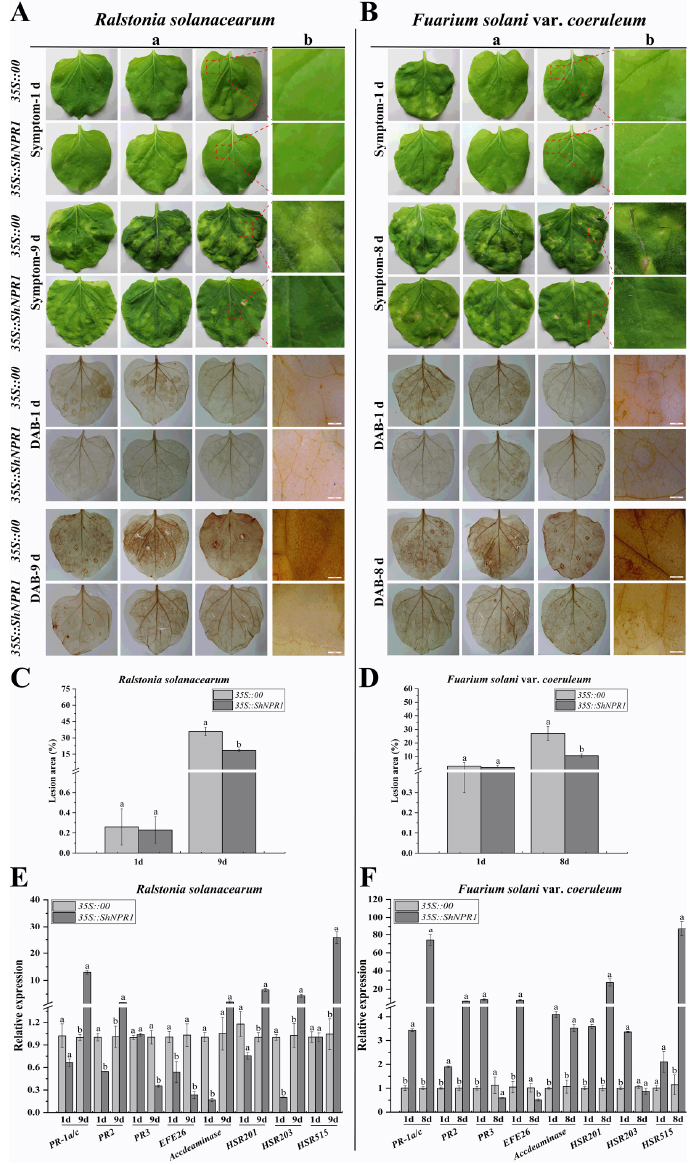
Figure 10. The immune effect of transient overexpression of ShNPR1 in Nicotiana benthamiana after inoculation with Ralstonia solanacearum and Fuarium solani var . coeruleum . ( A ) The disease symptoms and 3,3-diaminobenzidine (DAB) staining of N. benthamiana leaves at 1 day and 9 days post-inoculation with R. solanacearum . ( B ) The disease symptoms and DAB staining of N . benthamiana leaves at 1 day and 8 days post-inoculation with F . solani var. coeruleum . ( C ) Lesion area of leaves after infection with R. solanacearum . ( D ) Lesion area of leaves after infection with F . solani var. coeruleum . ( E ) Expression of eight tobacco-immune-related marker genes in the N . benthamiana leaves 1 day and 9 days after inoculation with R . solanacearum . ( F ) Expression of eight tobacco-immune-related marker genes in the N . benthamiana leaves 1 day and 8 days after inoculation with F . solani var. coeruleum . The tobacco- immune-related marker genes, namely salicylic-acid-pathway-related genes NtPR-1a / c , NtPR2 , and NtPR3 ; ethylene synthesis-dependent genes NtEFE26 and NtAccdeaminase ; hypersensitive reaction marker genes NtHSR201 , NtHSR203 , and NtHSR515 . NtEF-1 α was used for data normalization. (a) and (b) represent images taken with the Canon camera and a microscope (Bar = 2 mm), re- spectively. 35S::00 , the Agrobacterium tumefaciens strain carried the empty vector pEarleyGate 203; 35S::ShNPR1 , the A . tumefaciens strain carried the recombinant vector pEarleyGate 203- ShNPR1 . The bars represent the mean ± standard error ( n = 3). Different lowercase letters on the top of the bars indicate the significant differences determined by Duncan’s new multiple range test ( p- value <